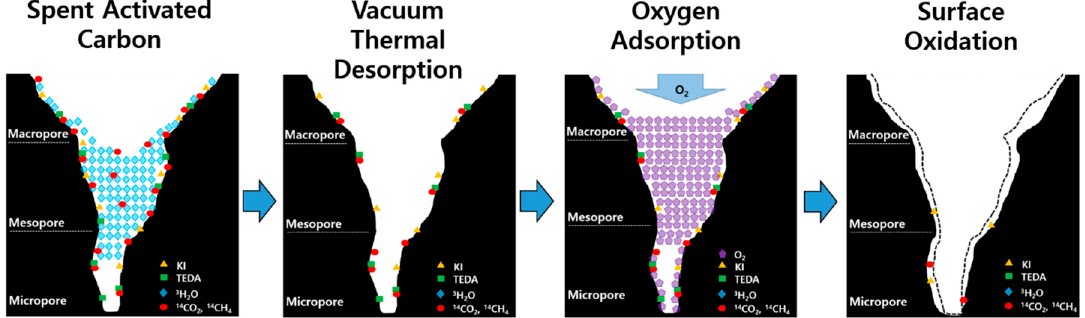
Figure 9. Mass schematic depiction of the thermal decontamination progress of spent activated carbon for a substantial removal of chemisorbed 14 C species.